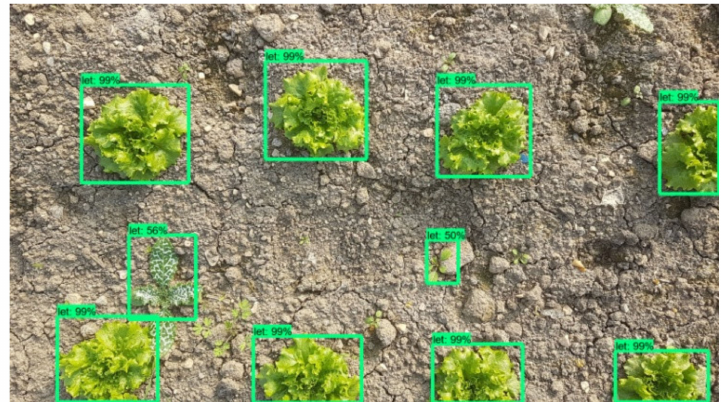
Figure 16. Plant detection and localization